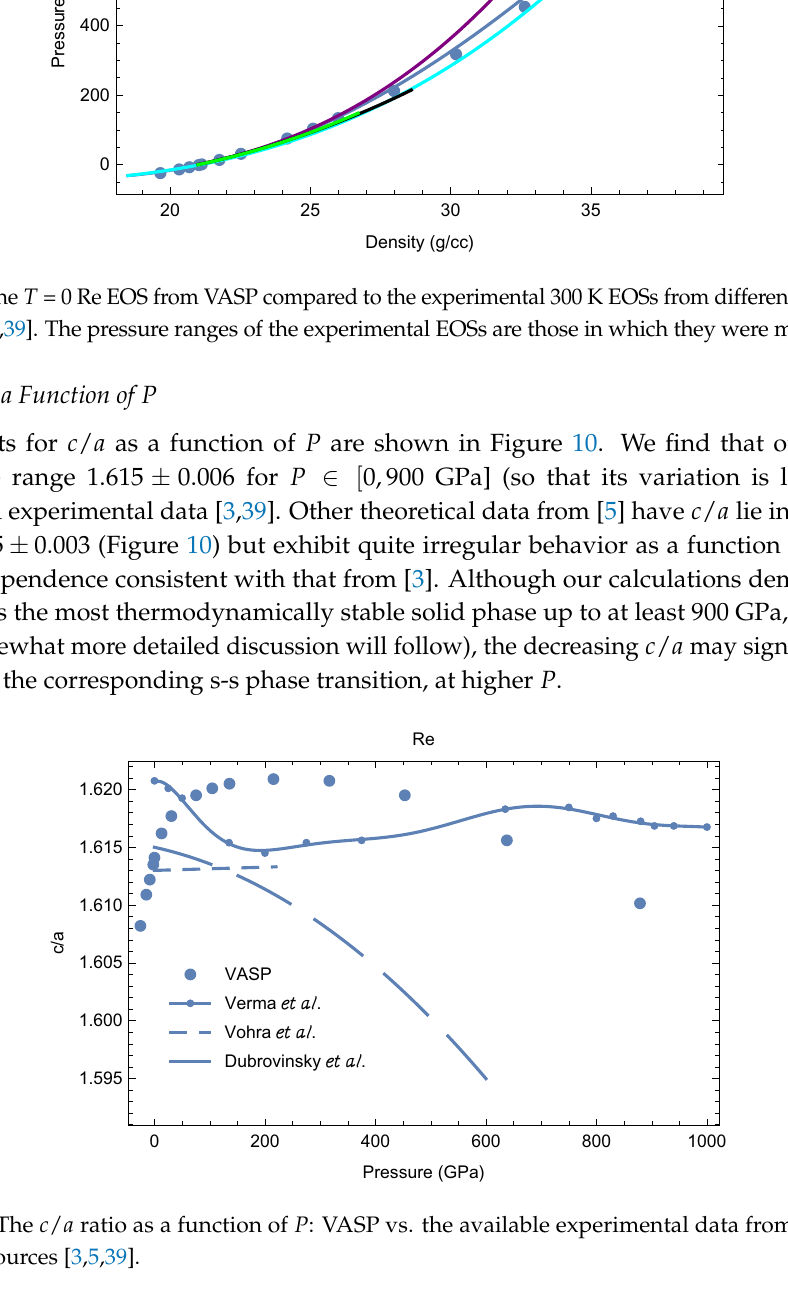
Figure 7. Time evolution of T for hcp-Re in three QMD runs with initial temperatures ( T 0 s) separated by 500 K. The middle run is the melting run, during which T decreases from ∼ 12000 K for the superheated state to ∼ 10000 K for the liquid at the corresponding melting point.